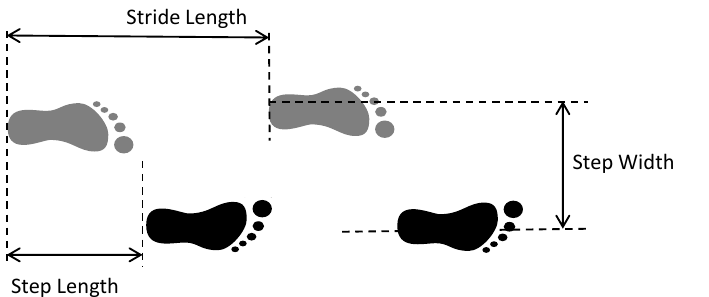
Figure 2. Important spatial gait parameters: step length, stride length, and step width. Black and grey shaded colors in footprints represent the right and left feet, respectively.